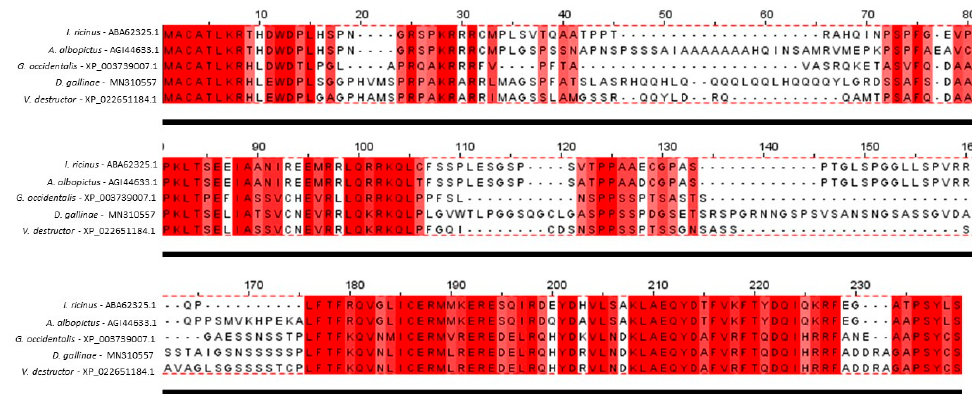
Figure 1. Amino acid protein sequence for D. gallinae AKR. Alignment of Deg-AKR amino acid sequence with AKR/SUB sequences from different species. Protein accession numbers are shown. In red are shown regions conserved across different species. The intensity of the red color indicates the level of conservation in that amino acid across the species. Alignment was carried out with Clustal Omega [23] and visualized with Jalview 2.11 software [24].